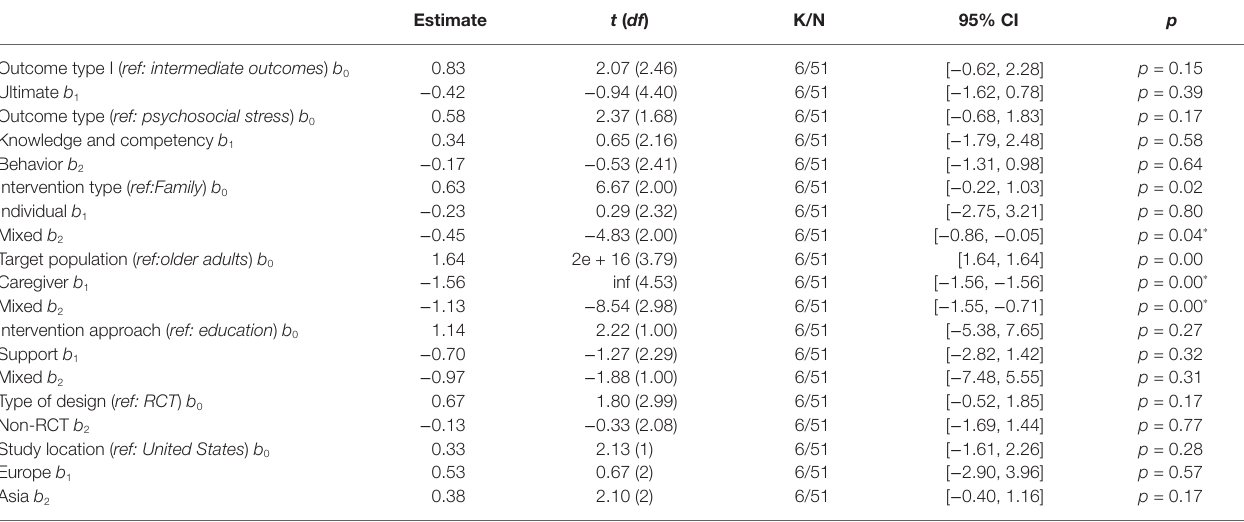
TABLE 3 | Single-predictor meta-regression